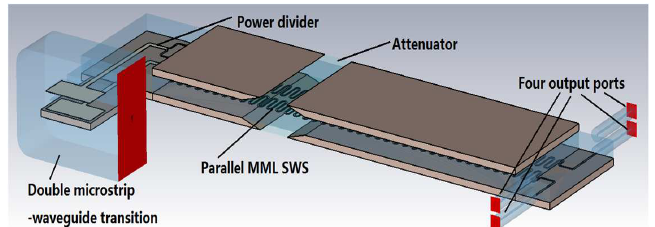
Figure 2. System schematic of the novel 2 × 2 amplifier units. This 2 × 2 amplifier unit is probably integrated for larger scale units with multiple methods for application in the T/R modules of the PARs. Based on the development of the multi-beam electron gun [13], one possible framework to compose 2 × 2n units is to simply